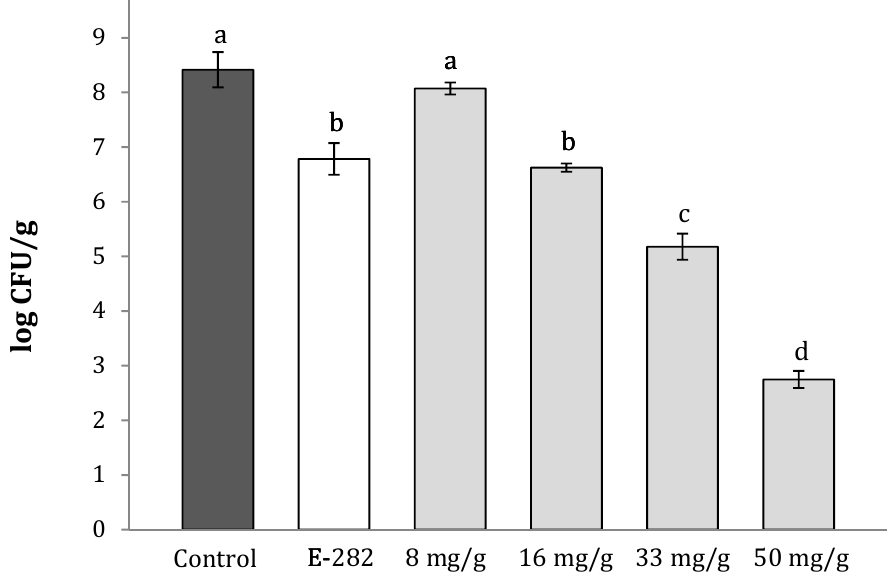
Figure 3. P. verrucosum growth in pita breads stored during 7 days in a plastic tray containing a small sachet sealed with 8, 16, 33 and 50 mg/g of oriental mustard flour sauce. Different letters show significant differences among treatments ( p ≤ 0.05).